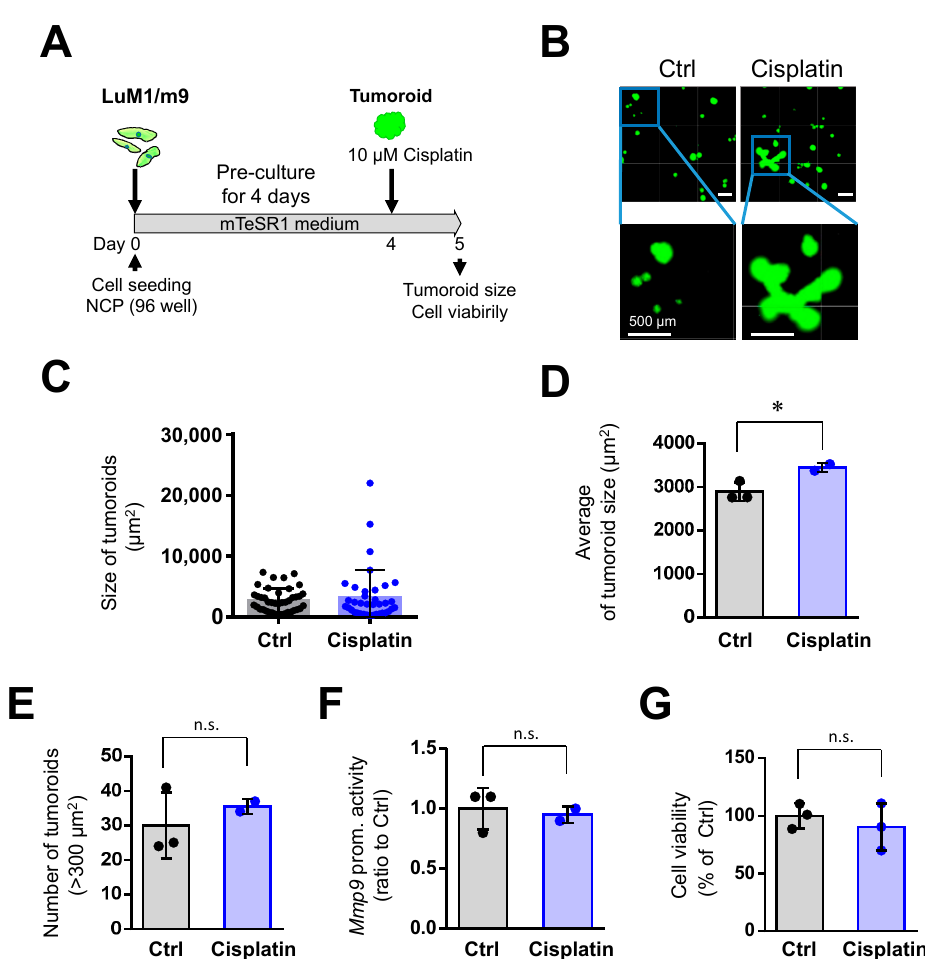
Figure 3. Cisplatin (at 10 µ M) promoted the tumoroid growth of mCRC cells: ( A ) a scheme of the experimental protocol used for panel B–G. LuM1/m9 cells were pre-cultured for 4 days in mTeSR1 on NanoCulture Plate ® (NCP), and then Cisplatin at 10 µ M was added; ( B ) representative images of tumoroids. Scale bars, 500 µ m; ( C ) column scatters the plotting of tumoroid size. Representative data from a single well were shown; ( D ) average tumoroid size. n = 2 or 3 independent culture wells; ( E ) the number of tumoroids larger than 300 µ m 2 . n = 2 or 3 independent culture wells; ( F ) Mmp9 promoter activity. n = 3 independent culture wells; and ( G ) cell viability. n = 3 independent culture wells. * p < 0.05, n.s., not significant.